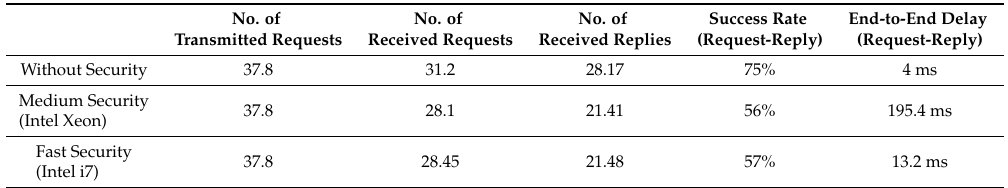
Table 7. Query Application